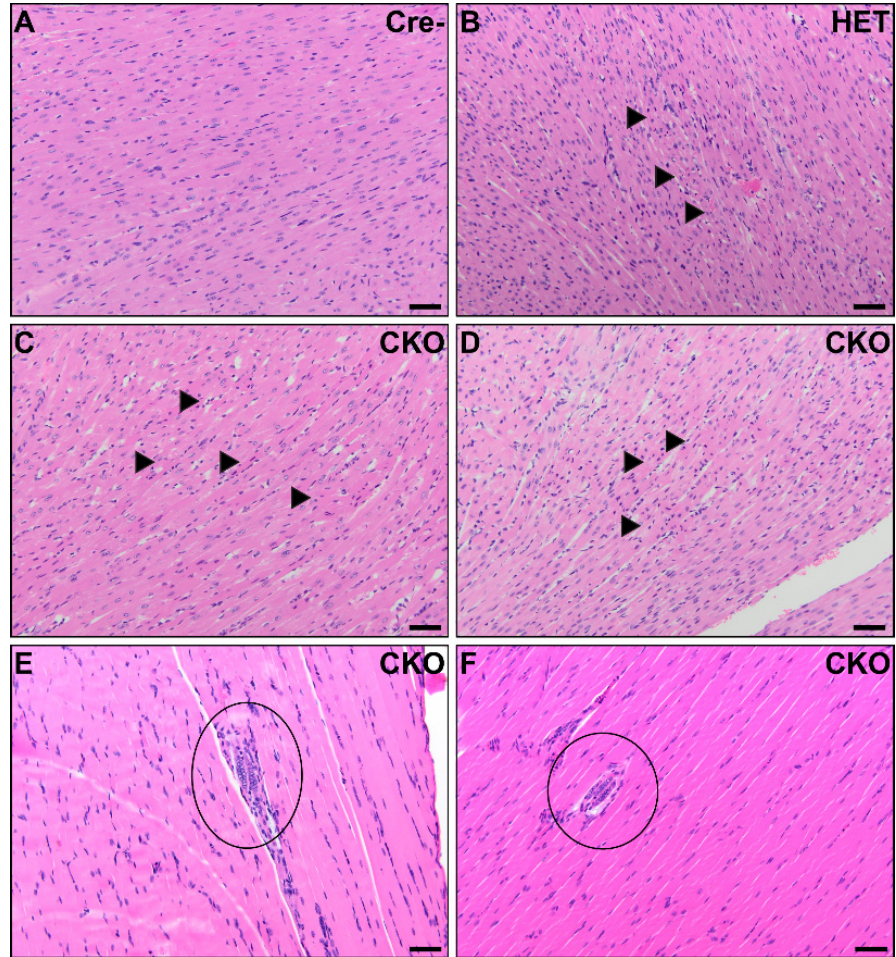
Figure 3. Cardiac and skeletal muscle pathology in CKO mice. In the myocardium, small foci consistent with acute myocardial necrosis were present in CKO mice ( C , D ) and one HET mouse ( B ). Minimal inflammation was present around the hypereosinophilic, disrupted, and disorganized cardiomyocytes with hyperbasophilic shrunken nuclei (arrows). No significant microscopic lesions were detected in the myocardium from Cre- age-matched control mice ( A ). There were multinucleated skeletal myofibers present in the diaphragm of two CKO mice (circles). Four CKO mice had similar multinucleated myofibers in perivertebral skeletal muscles. The skeletal muscle in the diaphragm was unremarkable in Cre- control mice. Scale bars ( A – F ) = 50 µm.